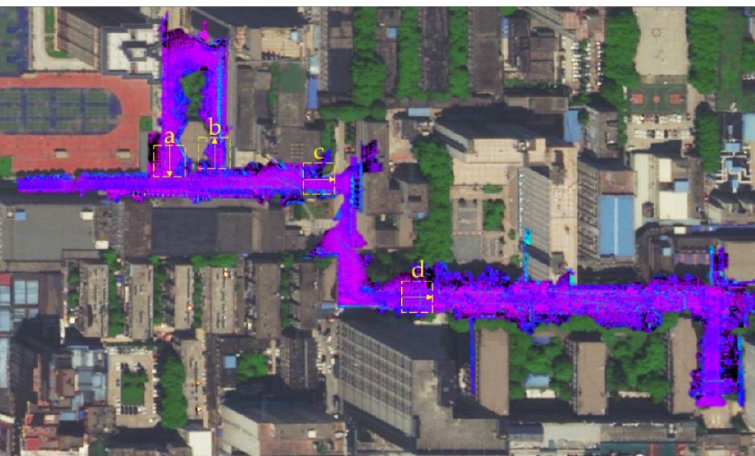
Figure 6. The VIAL-SLAM map aligned with Google Earth.